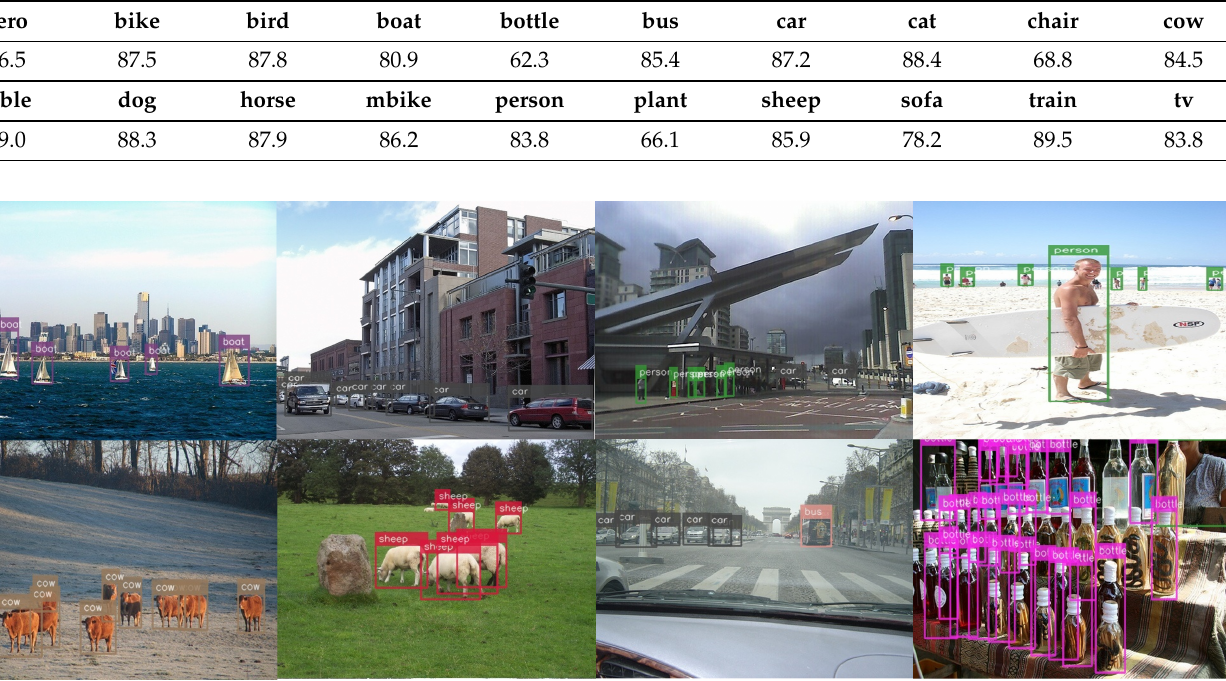
Figure 6. Detection results of the PASCAL VOC 2007 test data set. The network used in the experiment uses an input resolution of 512 × 512, and EfficientNet-B0 is used as the backbone network. (Number of classification classes: